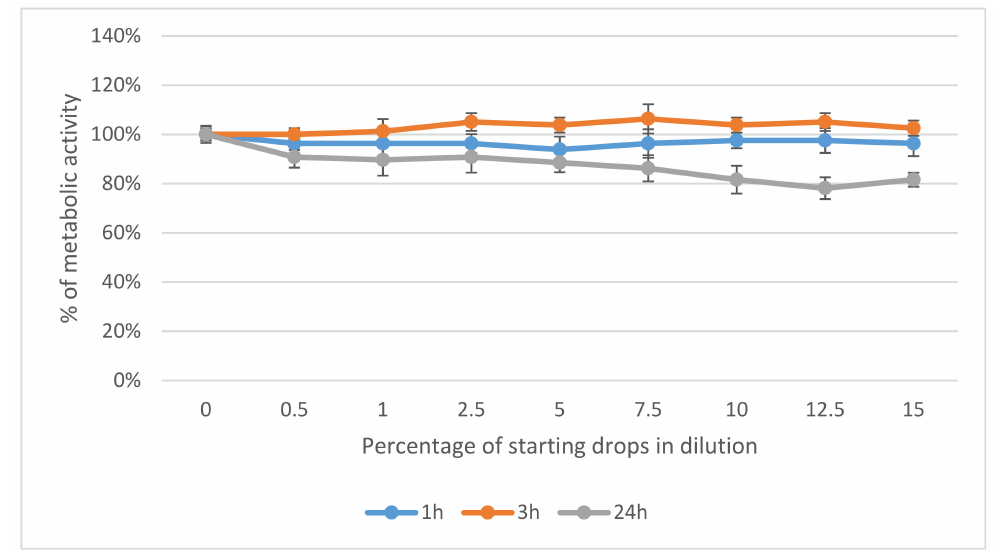
Figure 3. Effect of Ozodrop ® preparation on metabolic activity of human corneal epithelium (pRSV- T) in vitro, after 1, 3, and 24 h of incubation. Cell metabolic activity was determined by means of an MTT